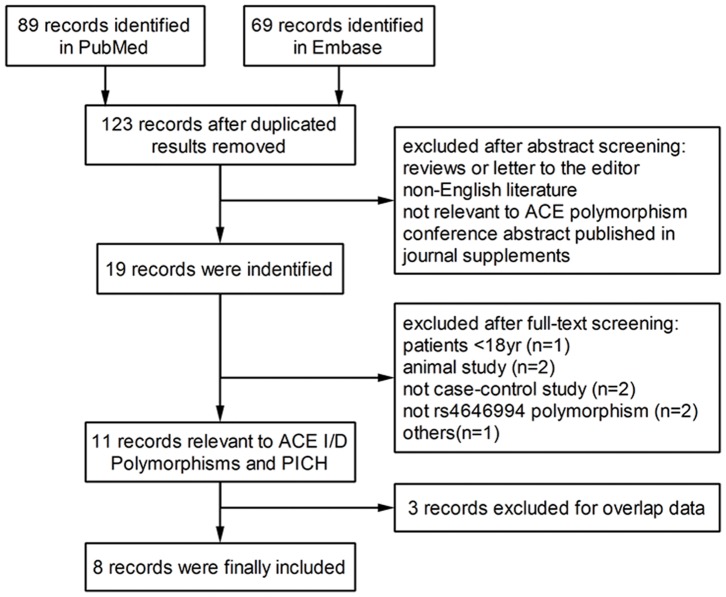
Study selection and exclusion.Flowchart of retrieved and excluded studies, with specification of the reasons.